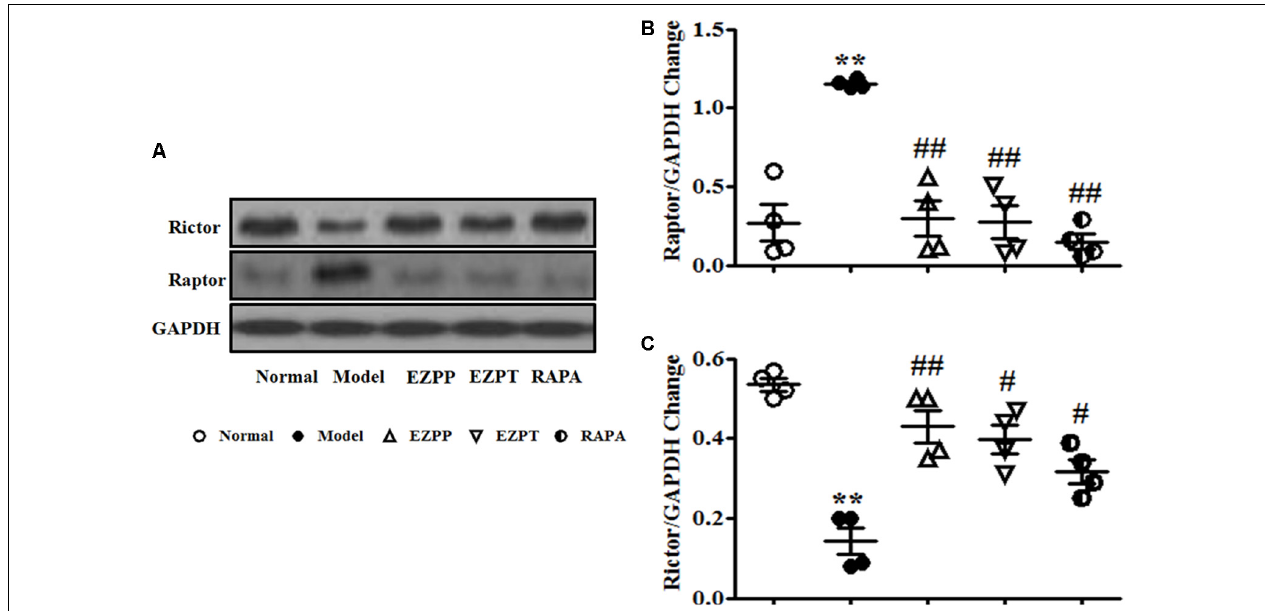
FIGURE 7 | Western blotting of Raptor and Rictor. (A) Western blotting of Raptor and Rictor. (B) Quantitative analysis of Raptor. (C) Quantitative analysis of Rictor. Data are presented as mean ± SEM ( n = 3). ∗∗ p < 0.01 versus Normal group; # p < 0.05 and ## p < 0.01 versus Model group.